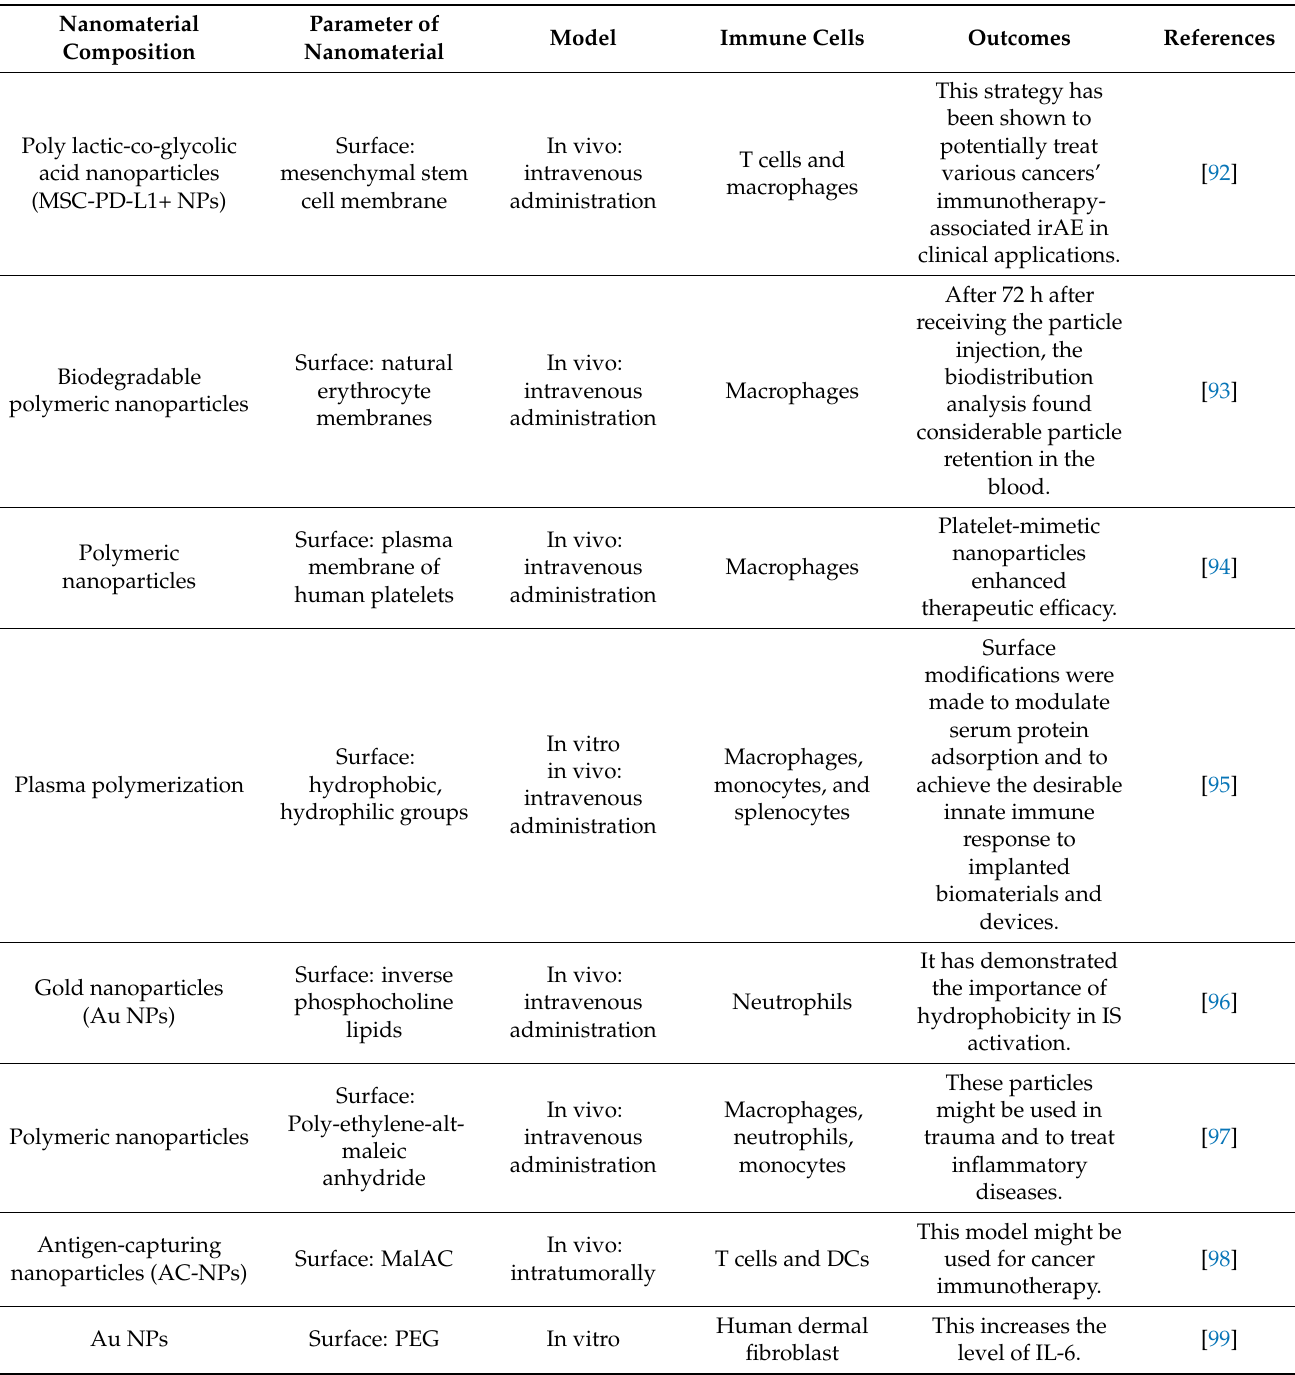
Table 2. Nanomaterial-induced immune responses concerning nanomaterials’ physicochemical properties, such as surface, charge, rigidity, shape, and